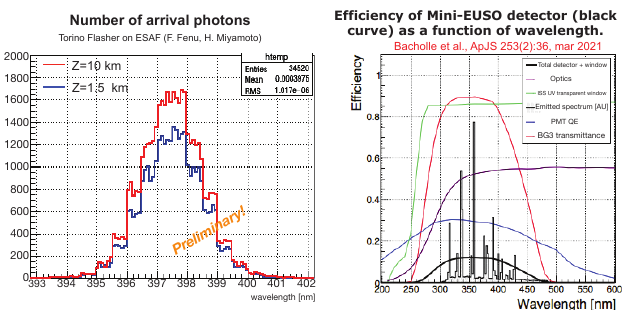
the obtained photon counts with “on-axis” value (red dot- ted curve). The measurement was then repeated after ro- tating the lens of flasher LED to check the dependency on the uniformity of the lens (blue dotted curve).